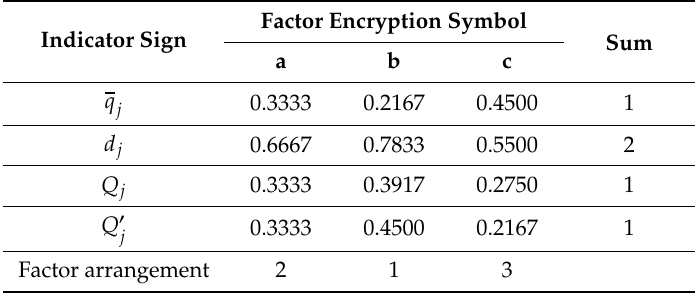
Table 6. Table illustrating the evaluation of